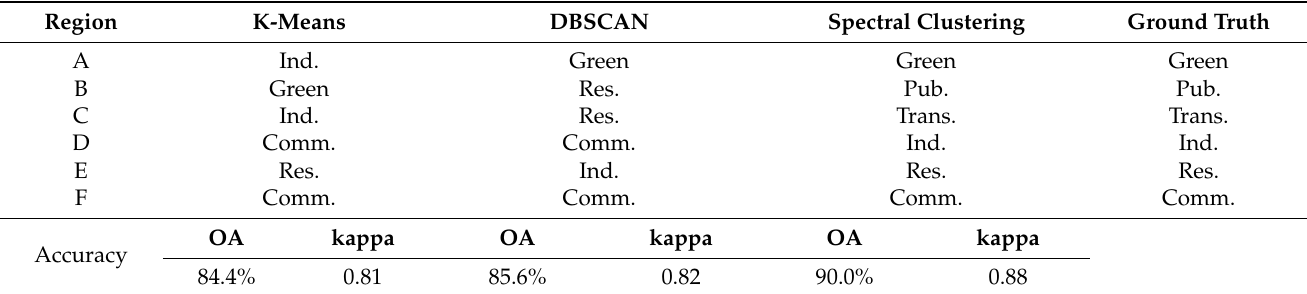
Figure 8. Identification results of the clustering methods: ( a ) k-means, ( b ) DBSCAN, and ( c ) spectral clustering. (Different circles denotes that the 6 typical regions for qualitative validation. The results were shown in Table 7). Table 7. Comparison results and accuracy of the different clustering methods.